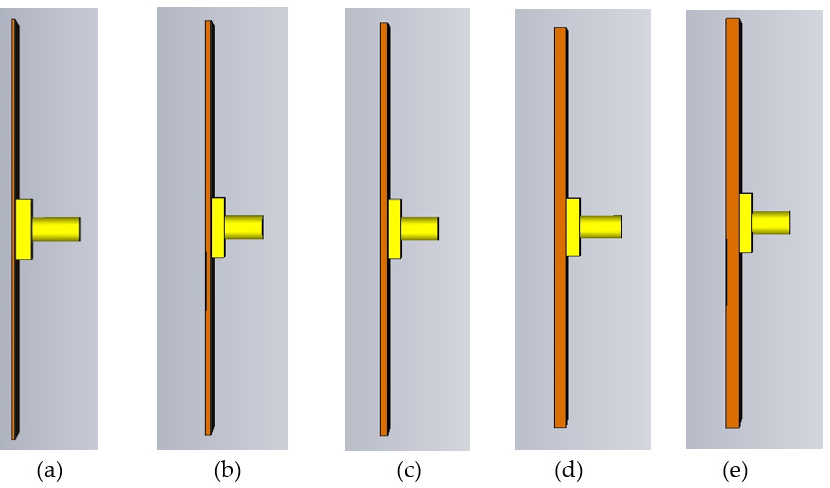
Figure 7. PDMS-Ferrite substrate thickness; ( a ) 0.4 mm, ( b ) 0.8 mm, ( c ) 1.2 mm, ( d ) 1.6 mm and ( e ) 2.0 mm.